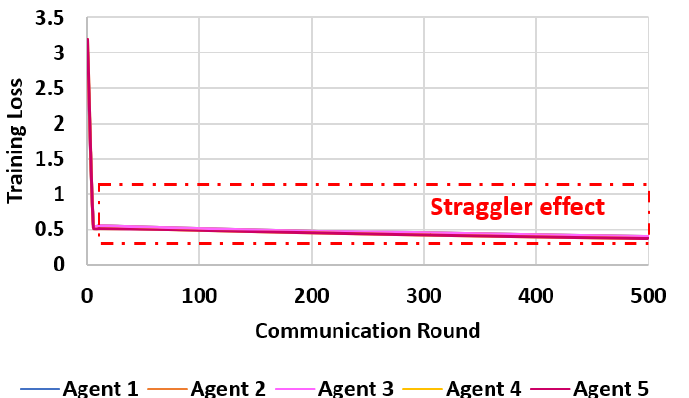
Figure 11. Straggler effects on participating FL agents’ (five agents and three stragglers) model loss for the prediction of agents’ resource-sharing